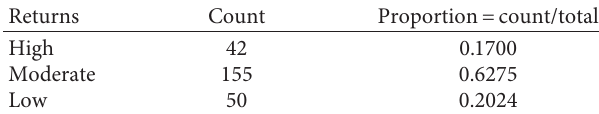
Table 5: Single-variable classification of returns.